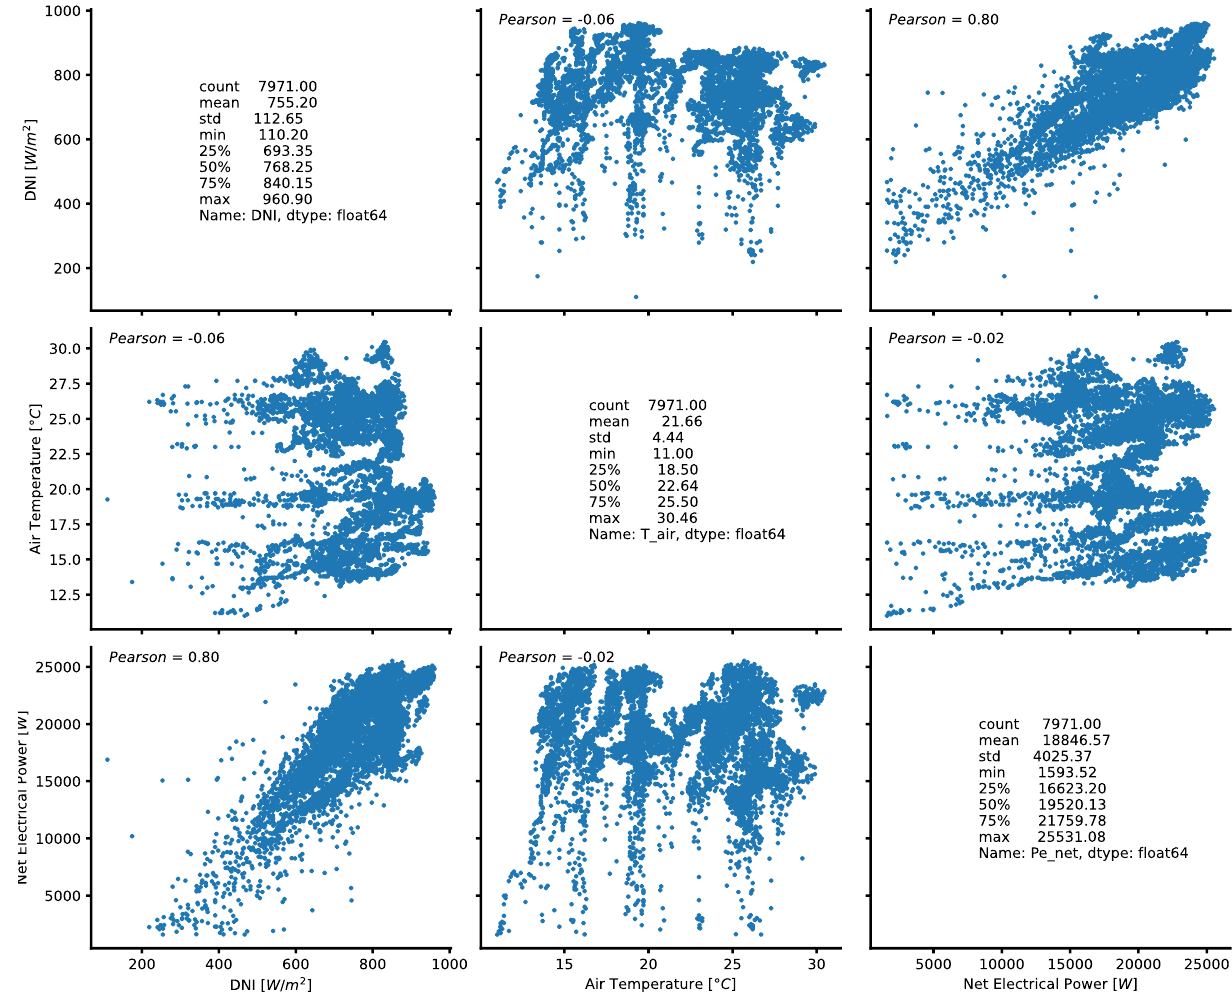
Figure 4. Statistical analysis of some variables included in the original dataset.